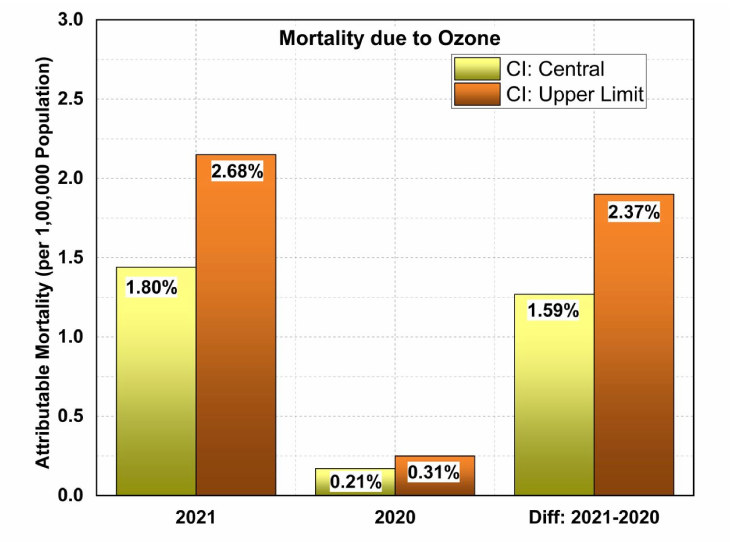
Figure 4. Attributable mortality (with confidence interval of central and upper limit) per 100,000 pop- ulation due to surface ozone in the lockdown period in 2021, 2020, and the difference between them, estimated using the AirQ+ software tool (the percentage mortality is displayed on the bar